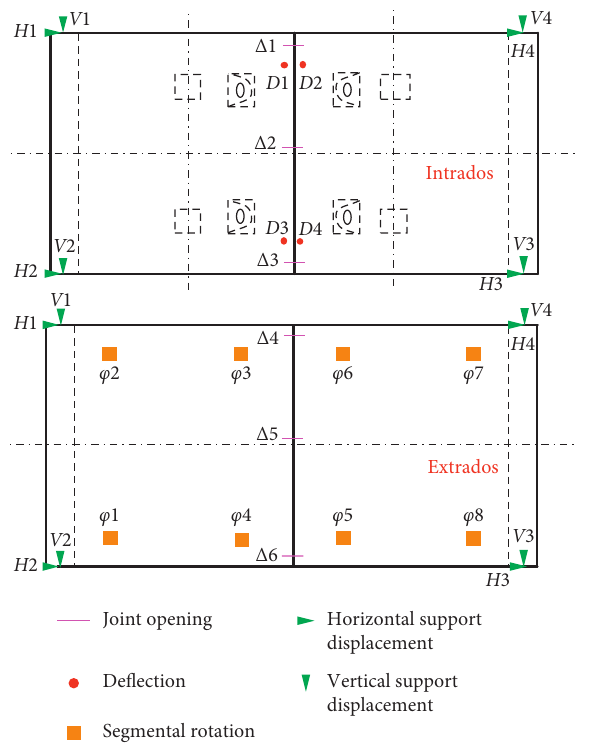
Figure 2: Layout of displacement meters and